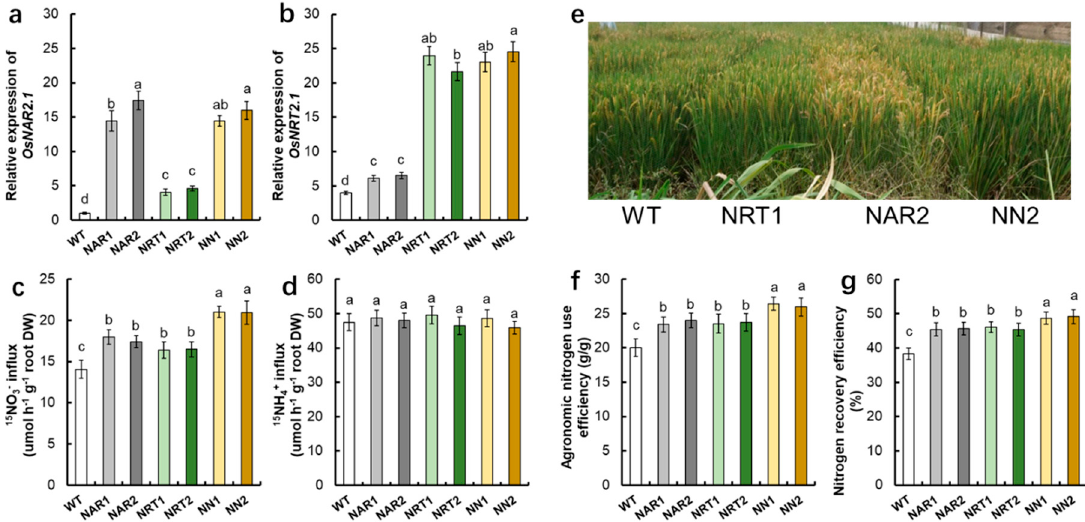
Figure 2. Co-overexpression of OsNRT2.1 and OsNAR2.1 increased nitrogen use efficiency in transgenic rice plants. qRT-PCR analysis showed the expression of ( a ) OsNAR2.1 and ( b ) OsNRT2.1 of WT, p35S:OsNAR2.1 transgenic lines (NAR1, NAR2), p35S:OsNRT2.1 transgenic lines (NRT1, NRT2), and p35S:OsNAR2.1-p35S:OsNRT2.1 transgenic lines (NN1, NN2). RNA was extracted from root. Error bars: SE ( n = 3). ( c , d ) 15 N influx rates of transgenic lines. WT and transgenic seedlings were grown in 1 mM NH 4+ for 3 weeks and nitrogen starved for 1 week. 15 N influx rates were then measured at ( c ) 0.5 mM 15 NO 3 − , ( d ) 0.5 mM 15 NH 4+ during 5 min. DW, dry weight. ( e ) Photograph of WT and transgenic lines in the field experiment. Comparison of ( f ) agronomic nitrogen use efficiency and ( g ) nitrogen recovery efficiency between the NP and transgenic lines. Error bars: SE ( n = 4). The different letters indicate a significant difference between the transgenic line and the WT ( p < 0.05, one-way ANOVA).